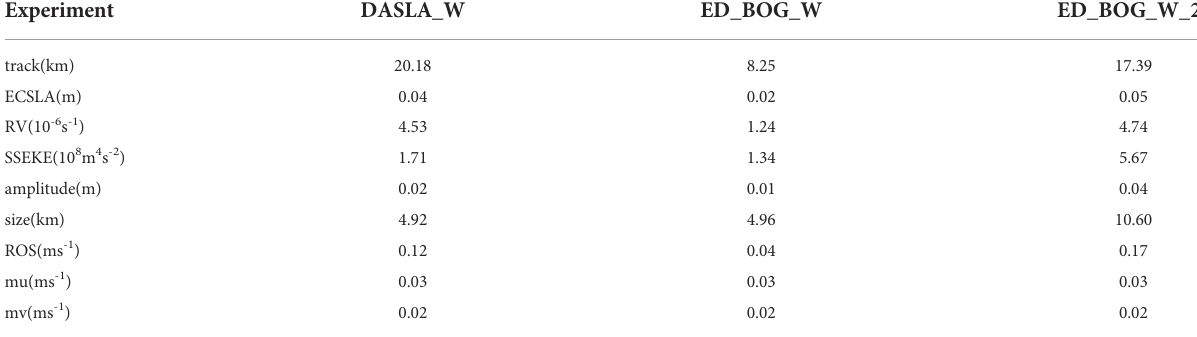
TABLE 3 The 30-day mean prediction error of the eddy feature variables from experiment DASLA_W, ED_BOG_W and ED_BOG_2J. Experiment DASLA_W ED_BOG_W